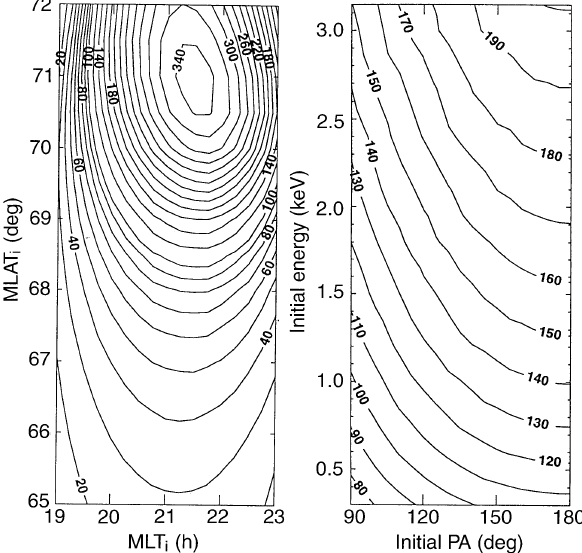
Fig. 5. The isolines of the equatorial energy of the 3-keV, 90 ° ion vs local time and latitude of launching ( left ) and the equatorial energy of ions launched at 2100 MLT, 69 MLAT as a function of ion initial energy and pitch angle ( right ). The isolines are labeled with energy in keV